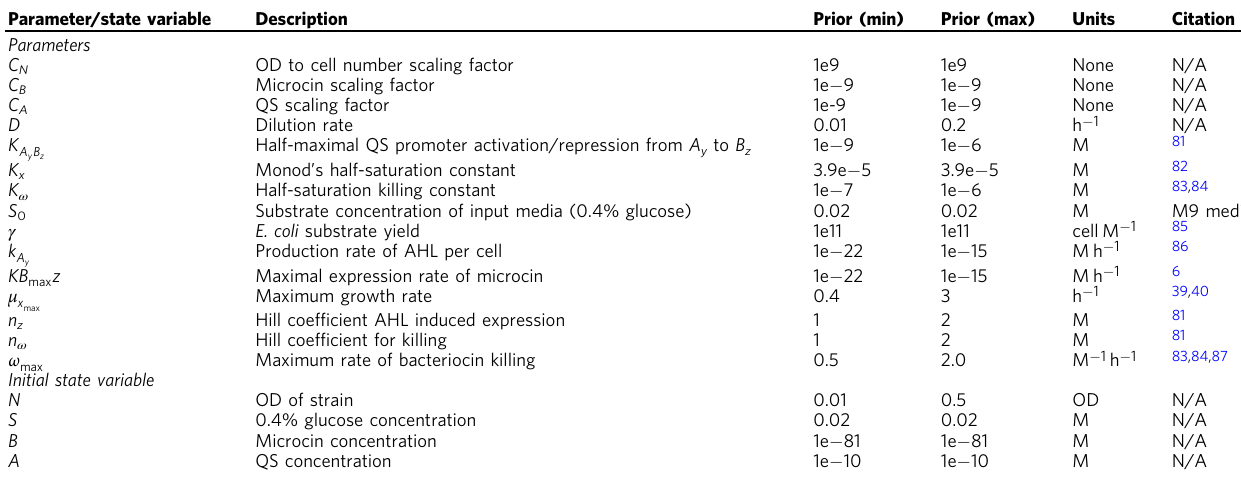
Table 1 Prior distributions for both two and three strain systems. Constant parameters have the same min and max value. K A KB z are sampled from log uniform distributions. The remaining parameters are sampled from uniform K A y and max